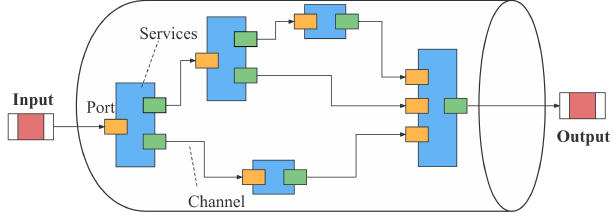
Figure 2. Task execution pipeline model.